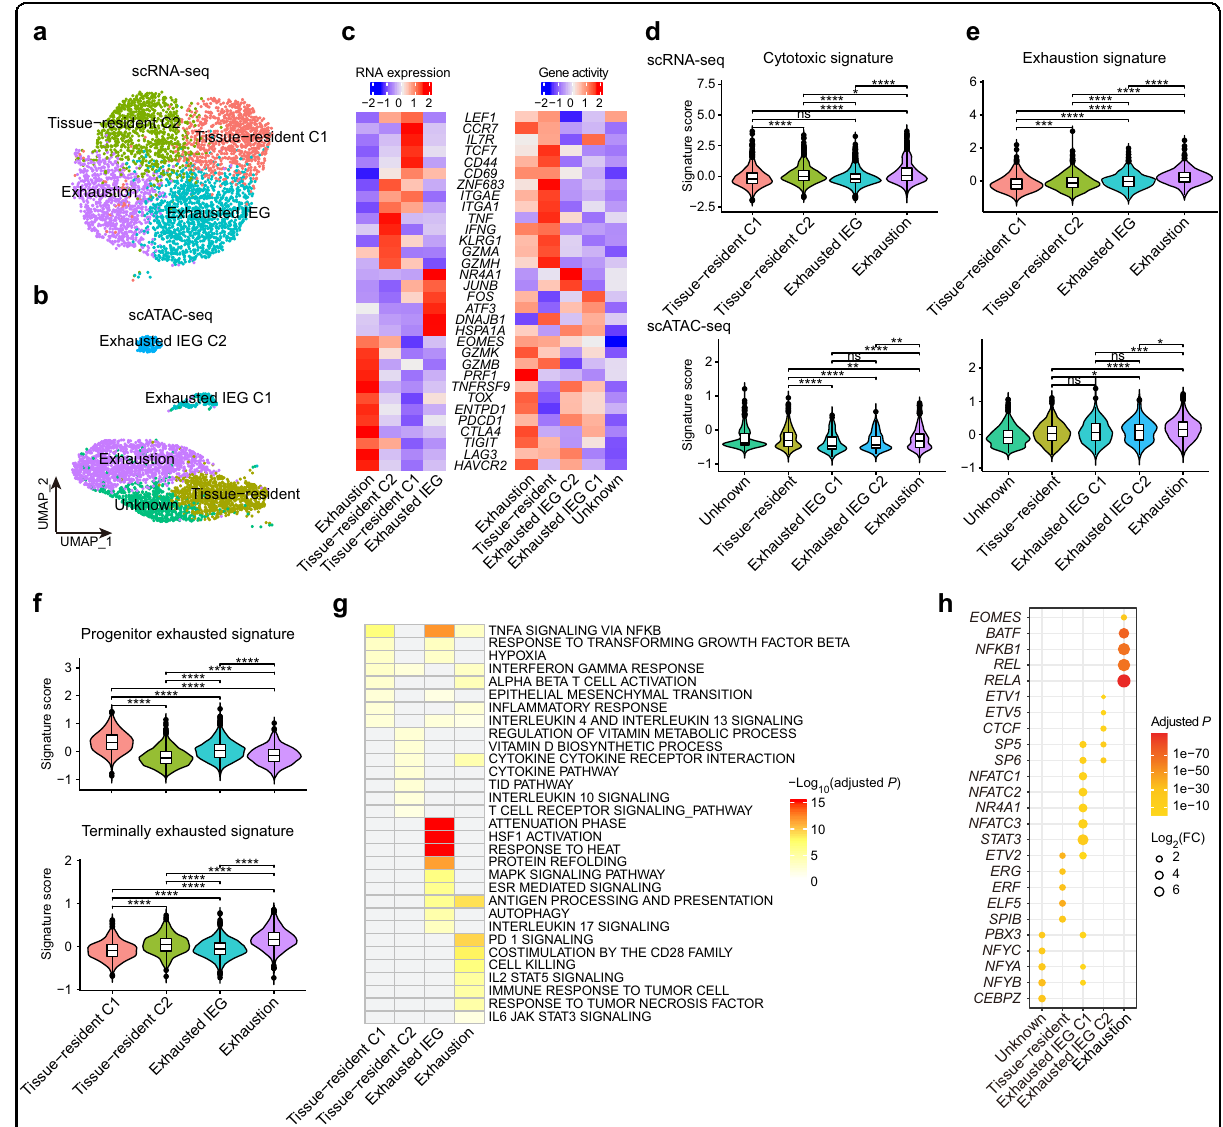
Fig. 5 Characterization of CD8 + T cells in ccRCC. a , b Subclustering of CD8 + T cells on the UMAP plots of the scRNA-seq and scATAC-seq datasets. c Heatmap of CD8 + T cell lineage and functional markers provided phenotypic information for individual CD8 + T cell clusters in the scRNA-seq (left) and scATAC-seq (right) data. d , e Violin plots showing the signature scores of cytotoxic and exhaustion gene sets for each CD8 + T cell cluster in the scRNA-seq (top) and scATAC-seq data (bottom). Signature scores for each cell were calculated by the VISION method. Two-sided Wilcoxon test. ns, no signi fi cance; * P < 0.05; ** P < 0.01; *** P < 0.001; **** P < 0.0001. f Violin plots showing the progenitor and terminally exhausted signature scores for each CD8 + T cell cluster in the scRNA-seq data. Signature scores for each cell were calculated by the VISION method. Two-sided Wilcoxon test. ns, no signi fi cance; * P < 0.05; ** P < 0.01; *** P < 0.001; **** P < 0.0001. g Heatmap of signi fi cantly enriched pathways for DEGs of each CD8 + T cell cluster in the scRNA-seq data. The darker the red color is, the smaller the adjusted P value. h Dot plot showing the top enriched TFs within each CD8 + T cell subpopulation